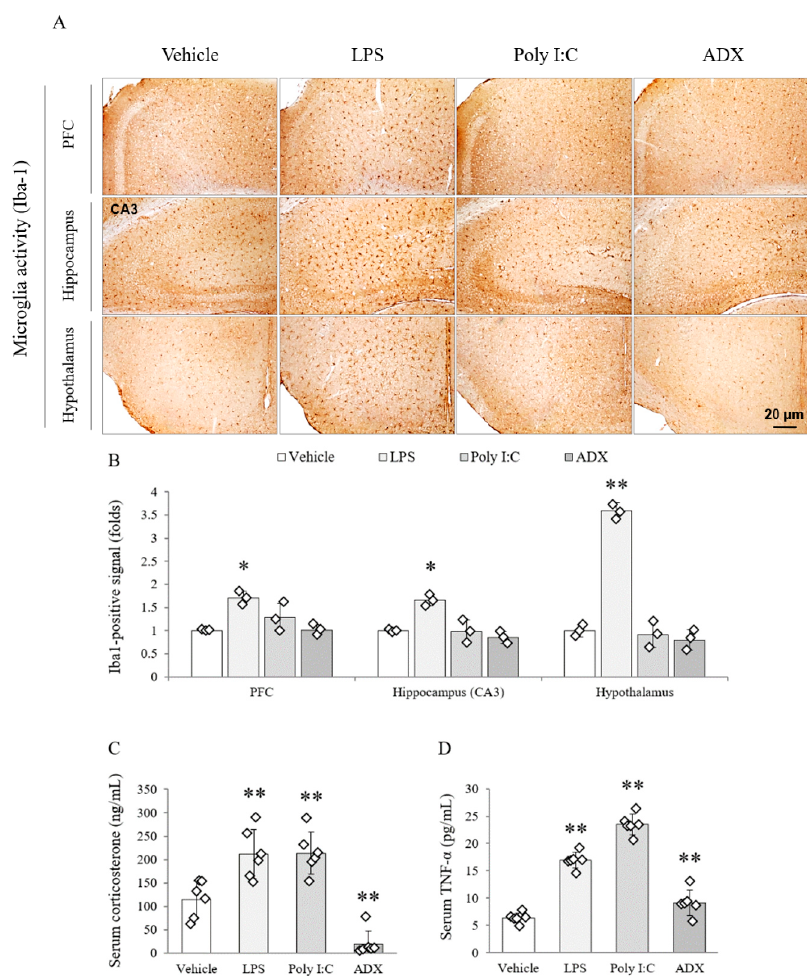
Figure 3. Microglial activity in brain regions and stress-related hormones and cytokines in serum. Iba1-positive stained microglia cells in the PFC, hippocampal CA3 and hypothalamus ( A ). Representative photomicrographs were taken at magnifications of 100×. Quantification of microglial activity in brain regions ( B ). Corticosterone ( C ) and TNF- α ( D ) in serum. Data are expressed as the means ± SD ( n = 3 or 6). *, p < 0.05; **, p < 0.01 compared with the vehicle group. PFC; prefrontal